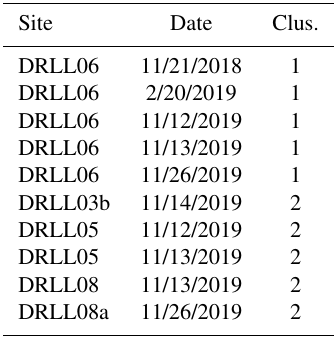
Table 3. Categorization of ice roughness via cluster analysis. Site Date